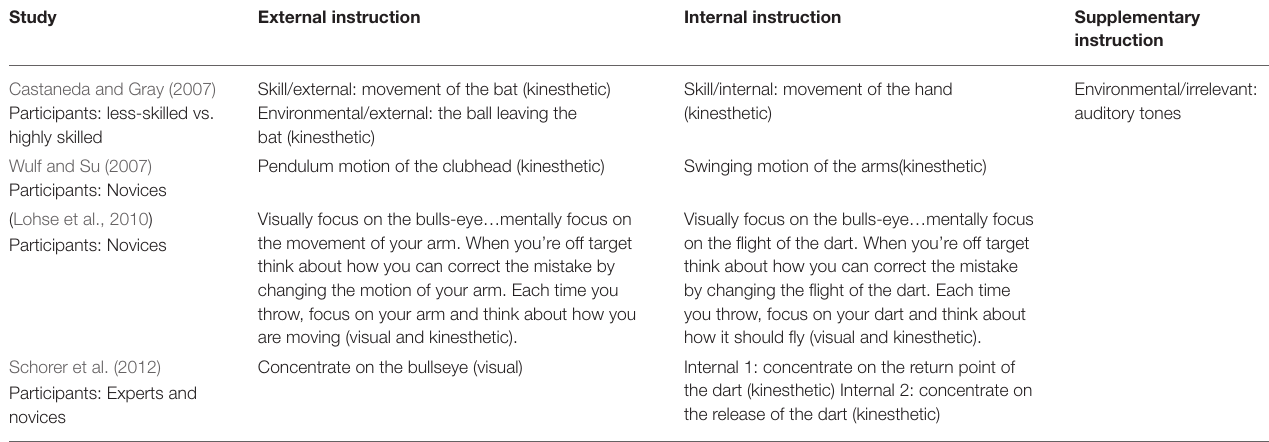
instruction Environmental/irrelevant: auditory